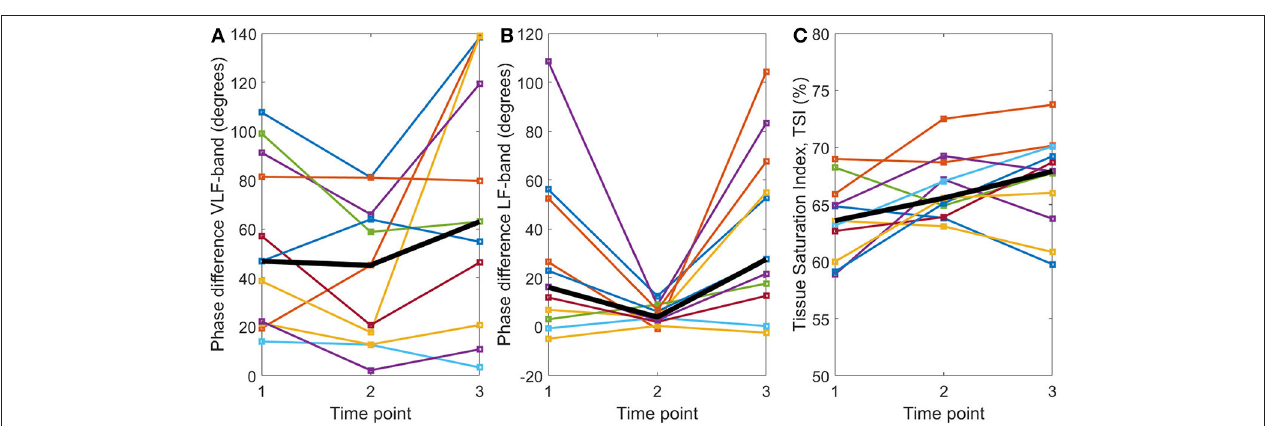
FIGURE 3 | TT-BF/BV-corrected phase differences (degrees) between OxyHb and HHb for the (A) very low frequency and (B) low frequency bands and (C) mean tissue saturation index (%) calculated with spatially resolved spectroscopy at three time points: (1) baseline, (2) systemic inflammation, and (3) at the end of the experiment. The per time point group median is shown by the black